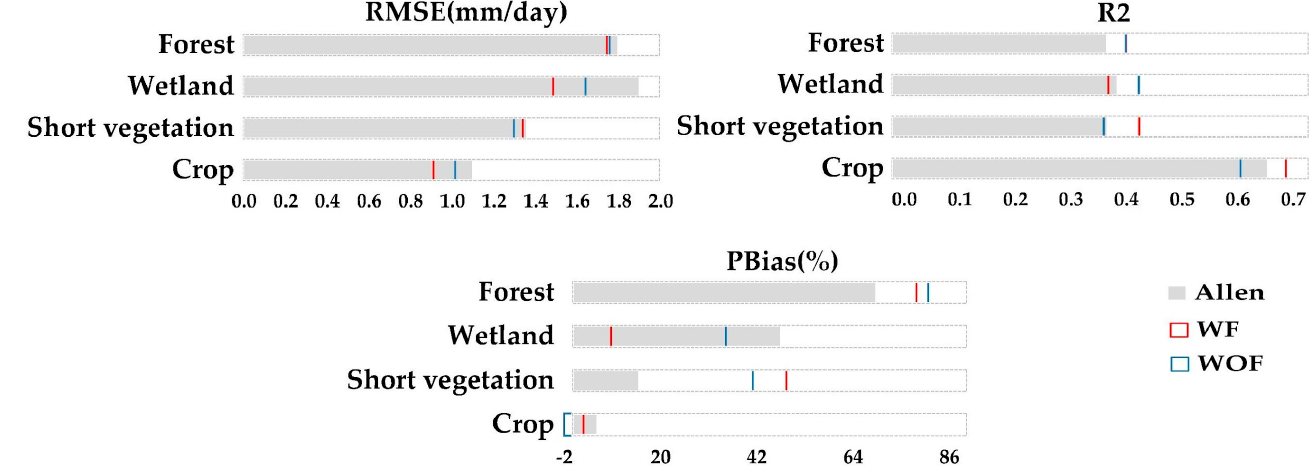
Figure A5. Evaluation of land cover-specific automated ET estimation performance.